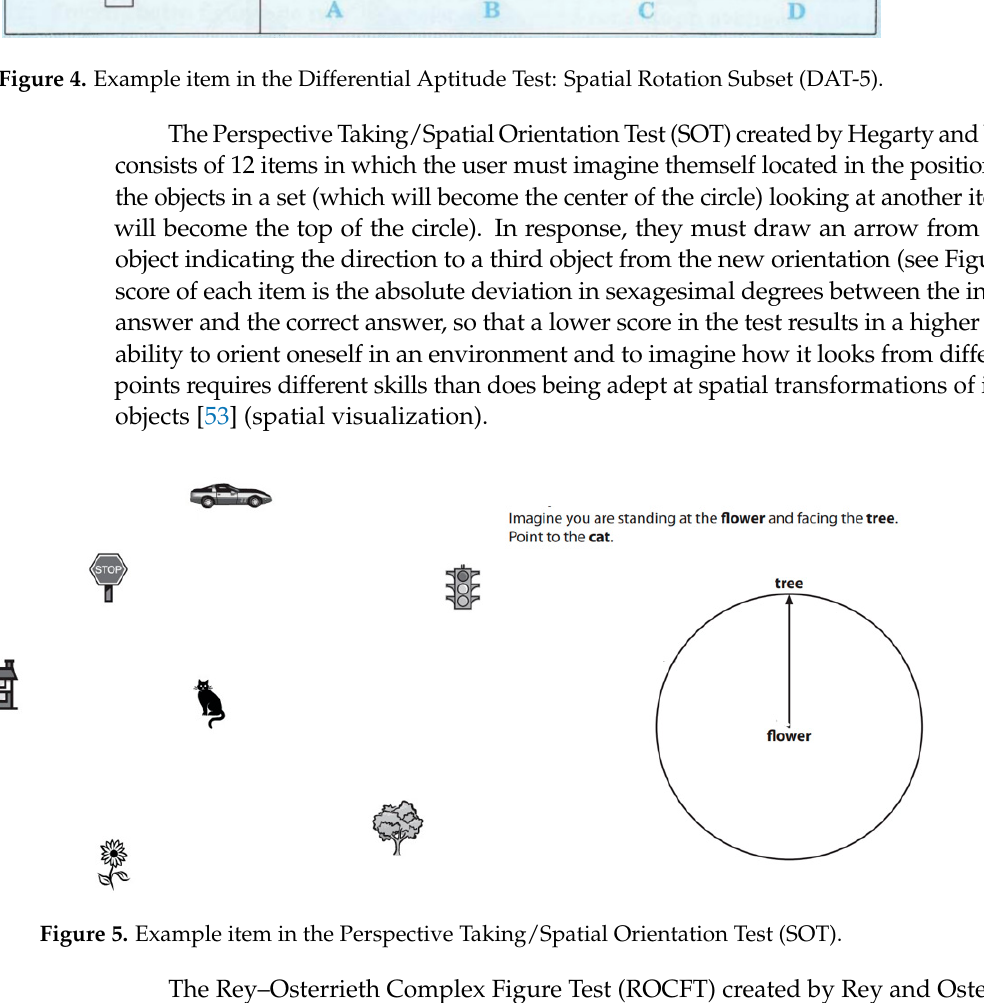
Figure 4. Example item in the Differential Aptitude Test: Spatial Rotation Subset (DAT-5).